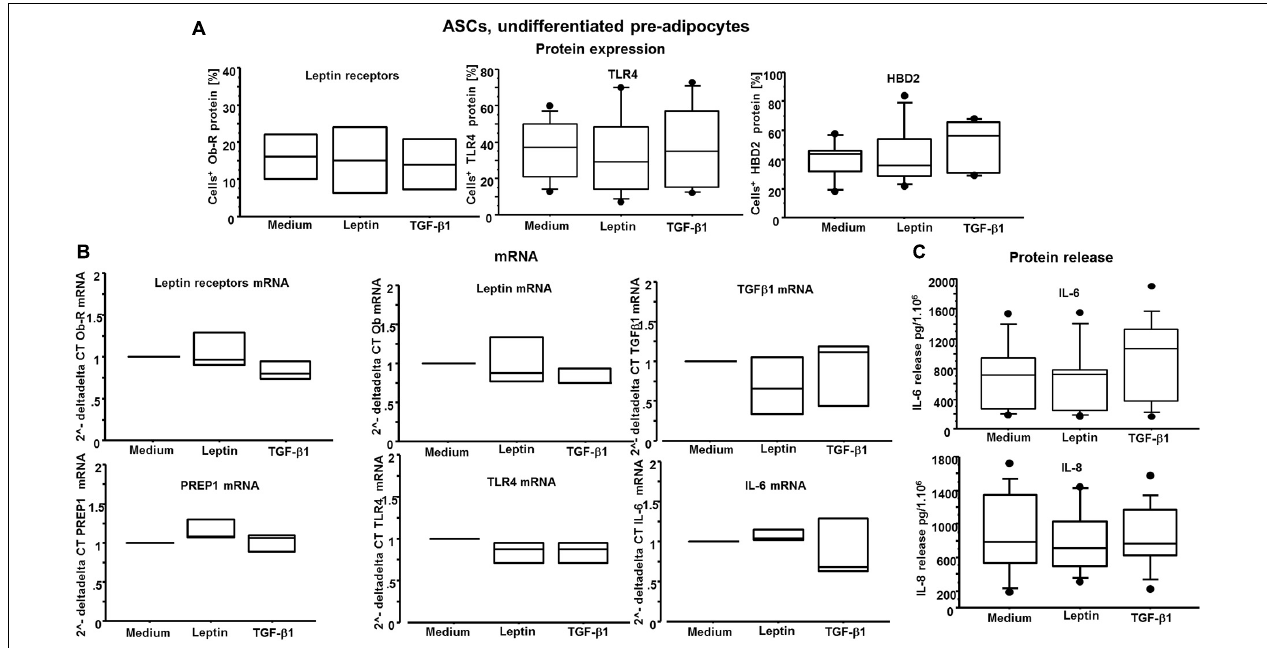
FIGURE 7 | (A) Flow cytometry analysis on ASCs for leptin receptors, TLR4 and HBD2: there are no significant differences among the conditions. (B) n = 3 experiments; quantitative real-time PCR of leptin and its receptors, TGF- β 1, PREP1, TLR4, and IL-6 transcripts: there are no significant differences among the conditions. (C) At least n = 7 experiments; IL-6 and IL-8 release by ASCs: there are no significant differences among the